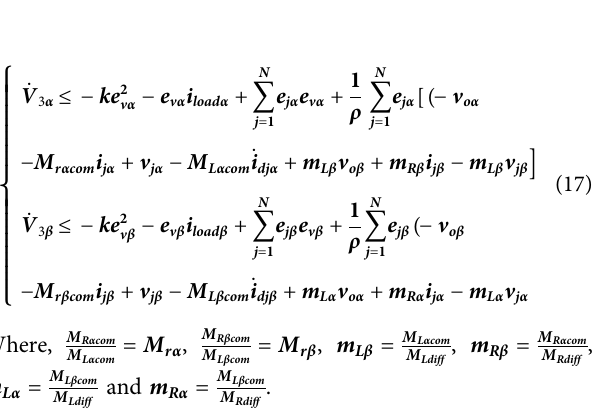
Frontiers in Energy Research |